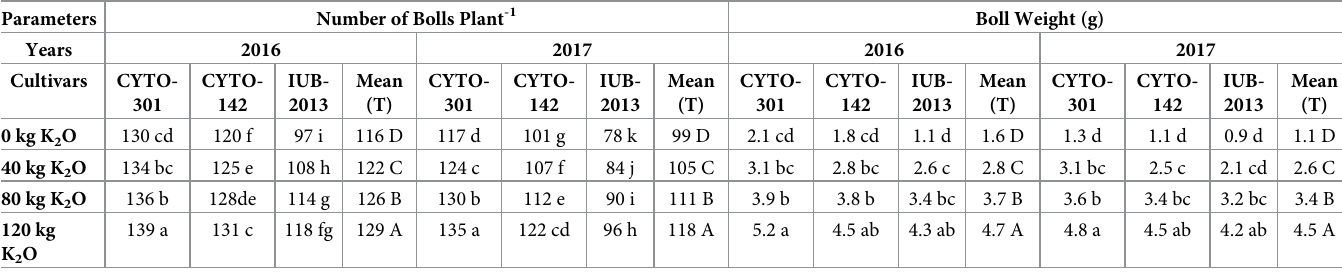
C = Cultivars, T = Treatments, NS = Non-significant, Different alphabets with in the same column or row indicate statistically significant differences.